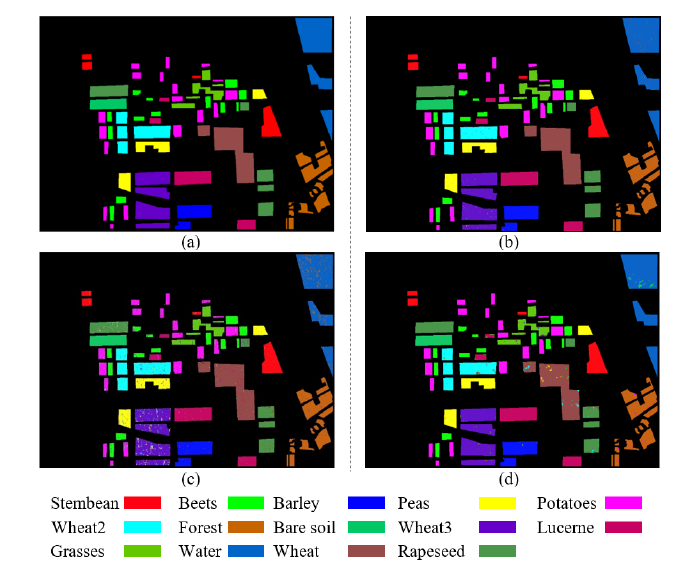
Figure 8. ( a – d ) represent the classification results of the ground-truth, Dual-CNN, 6Ch-CNN, and PauliRGB-CNN, respectively.